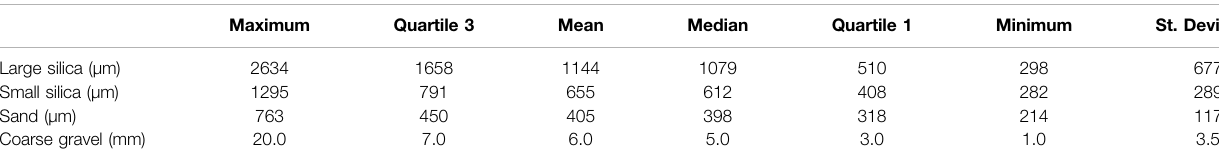
TABLE 2 | General descriptive statistics of the pores size of the porous medium materials.